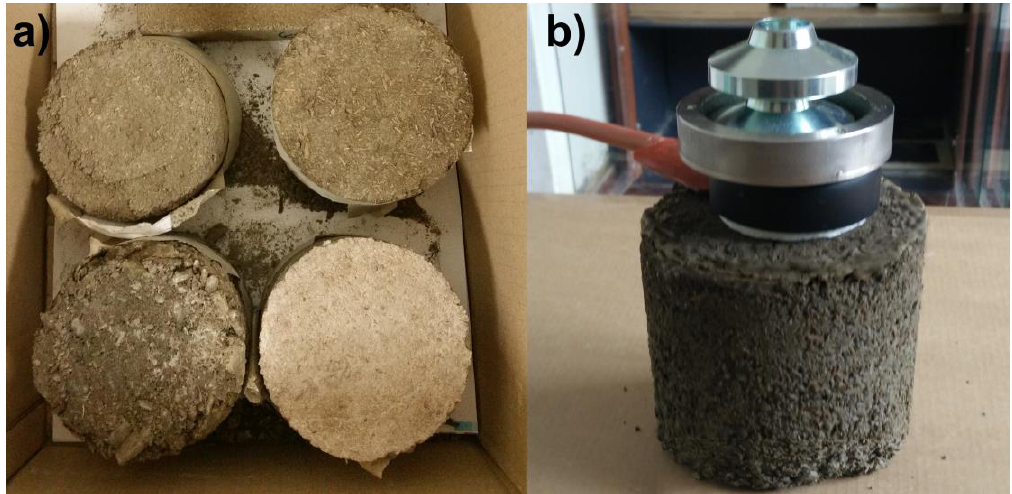
Figure 8. (a ) Mineralized samples; and ( b ) Hot Disk sensor positioning for mineralized samples. Figure 8. ( a ) Mineralized samples; and ( b ) Hot Disk sensor positioning for mineralized